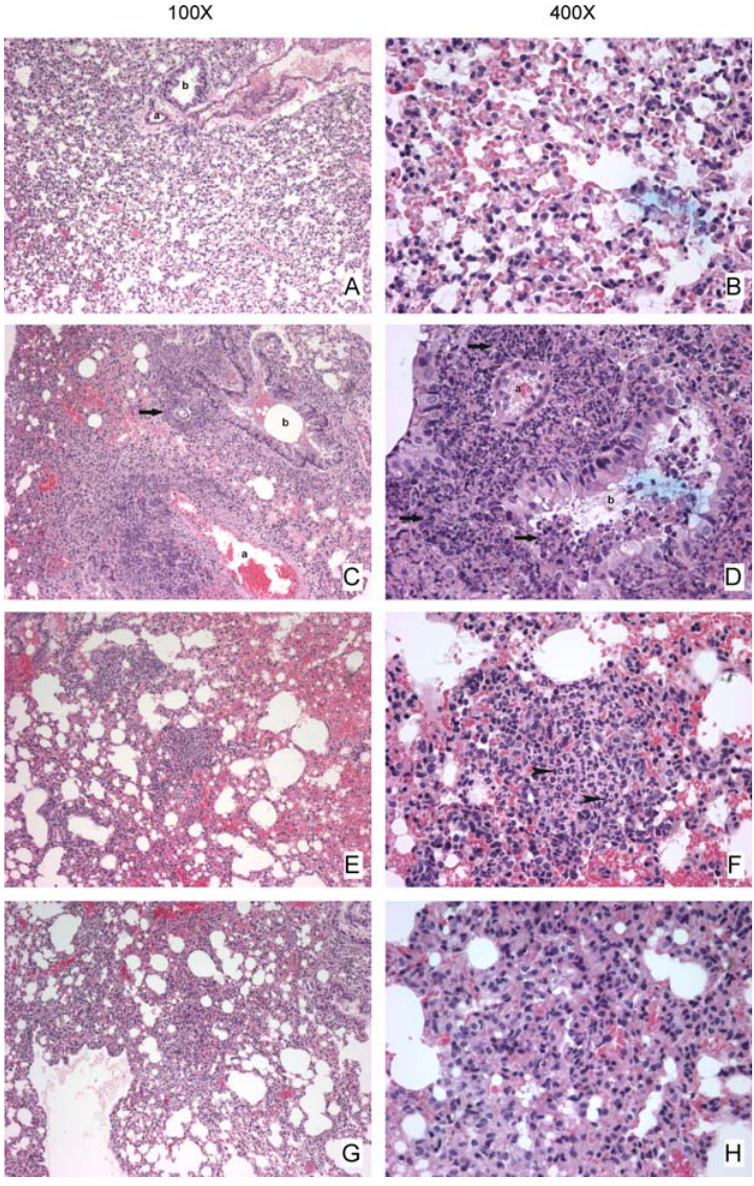
Figure 5. Histopathology of lungs from mice infected with Schu S4 derivatives. Mice were infected i.n. with 1 6 PBS (A, B), 100 CFUs of wild- type Schu S4 (C, D), or 10 6 CFUs of Schu S4 D purMCD (E, F). Infections were allowed to proceed for 5 days before animals were euthanized and lungs removed for histology. A subset of animals was also vaccinated i.n. with 10 4 CFUs of Schu S4 D purMCD and boosted i.n. 21 days later with 10 6 CFUs Schu S4 D purMCD . Animals were then administered 1 6 PBS 42 days post-vaccination (21 days post-boost) and euthanized 4 days later for histological analysis of lung tissues (G, H). Images were captured at 100 6 (A, C, E, G) or 400 6 (B, D, F, H) magnification. Representative arteries (a) and bronchioles (b) are labeled. Examples of neutrophils are indicated by black arrowheads and necrosis by black